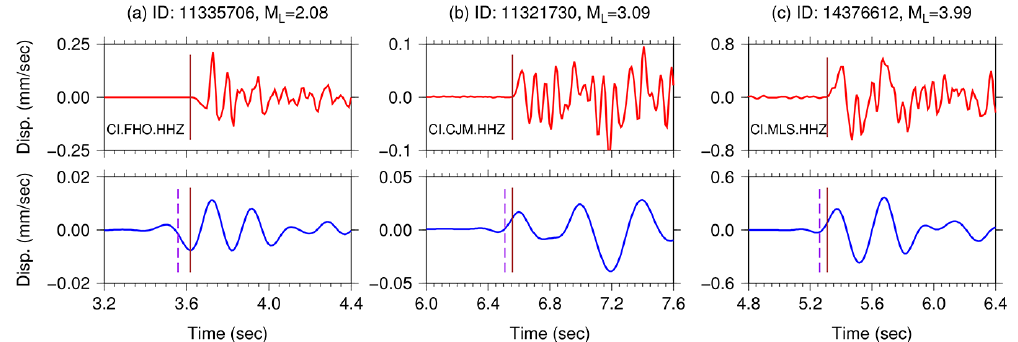
Figure 4. (a–c) Three examples of observed P wave arrival time picked on raw data obtained from the SCSN catalog (first row) and filtered seismograms filtered between 0 . 001Hz and 5.0Hz (second row). The brown lines denote the observed arrival-times T obs determined by data analysts, and the dashed purple lines are the possible arrival-times T obs,f manually picked on filtered seismograms. Earthquake IDs (such as 11335706), M L magnitudes, and station names (such as CI.CJM) are specified for each record. The observed arrival times on raw data and on filtered seismograms are (a) T obs = 3 . 618s, T obs,f ≈ 3 . 558s, (b) T obs = 6 . 558s, T obs,f ≈ 6 . 508s, and (c) T obs = 5 . 311s, T obs,f ≈ 5 . 261s. The differences δt f = are less than 0 . 06s.